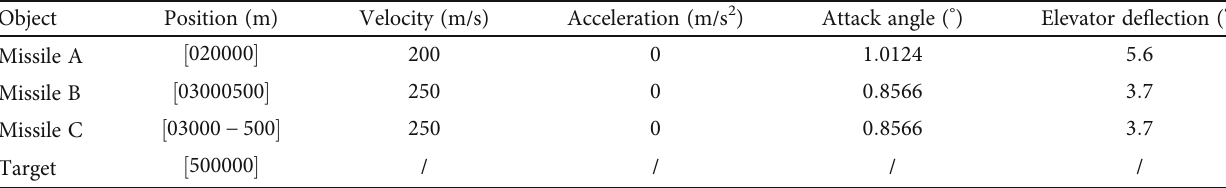
Table 1: Initial state of missiles and the target.